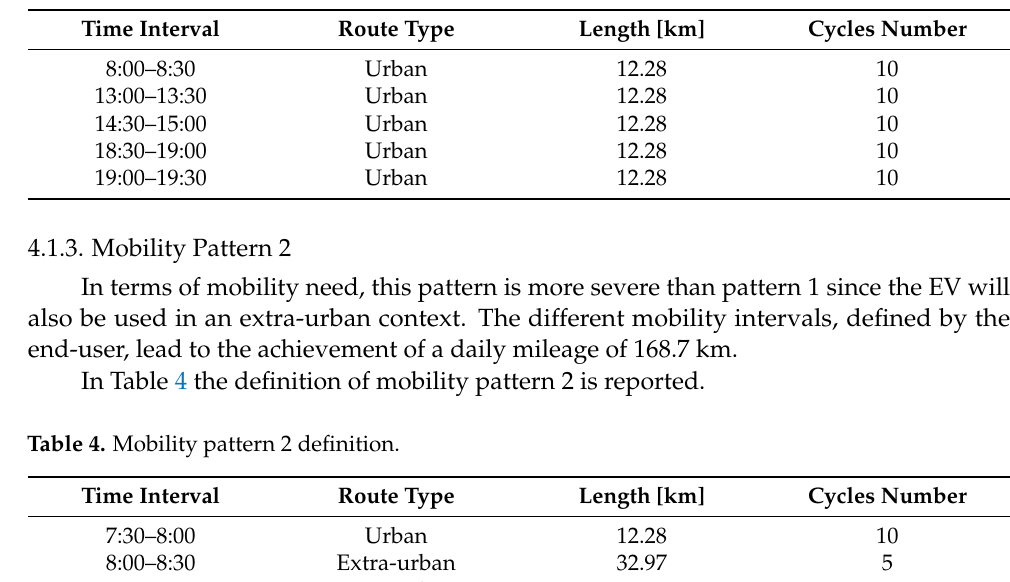
Table 3. Mobility pattern 1 definition.